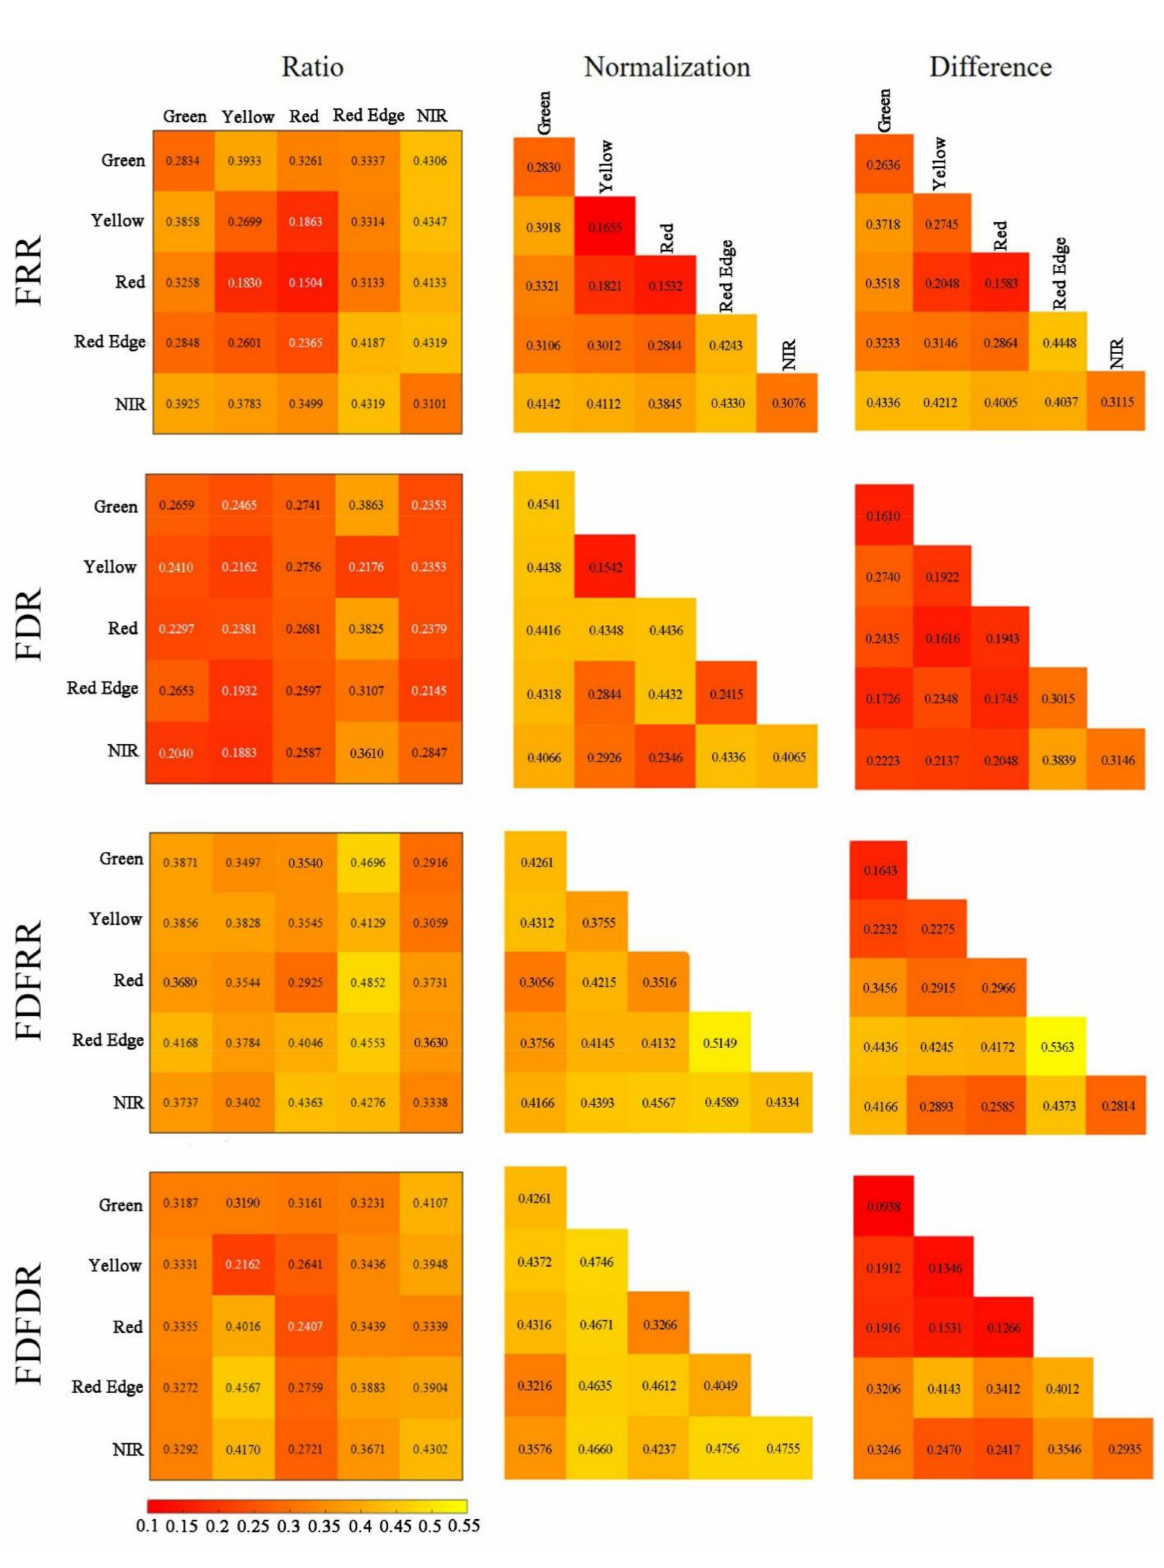
Figure 7. The combinations of high correlation florescence indices in the florescence ratio reflectance (FRR), the florescence difference reflectance (FDR), the first derivative florescence ratio reflectance (FDFRR) and the first derivative florescence difference reflectance